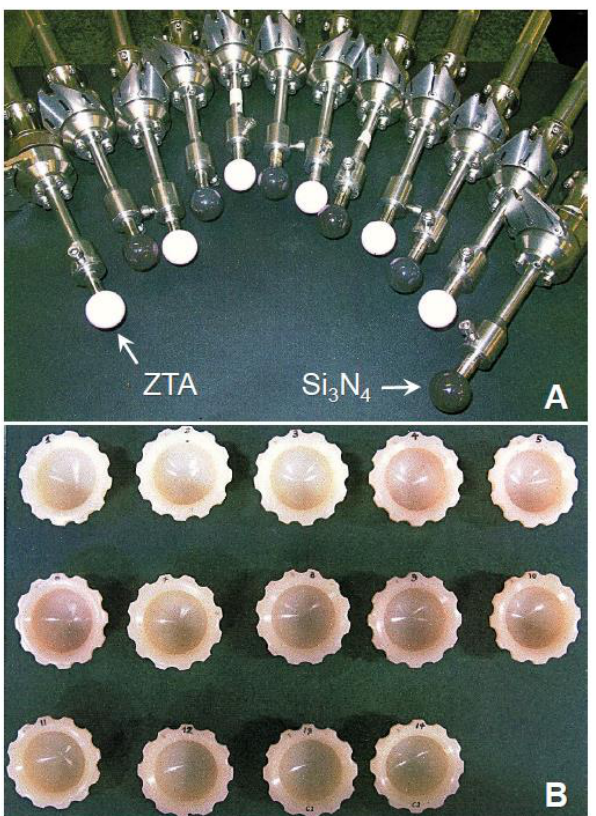
Figure 1. Photographs of ( A ) the tested femoral heads (Ø28 mm), zirconia (ZrO 2 )-toughened alumina (Al 2 O 3 ) (ZTA) (BIOLOX ® delta ) and Si 3 N 4 ( MC 2 ® ), and ( B ) vitamin-E-diffused crosslinked polyethylene (Vit-E XLPE) cups.